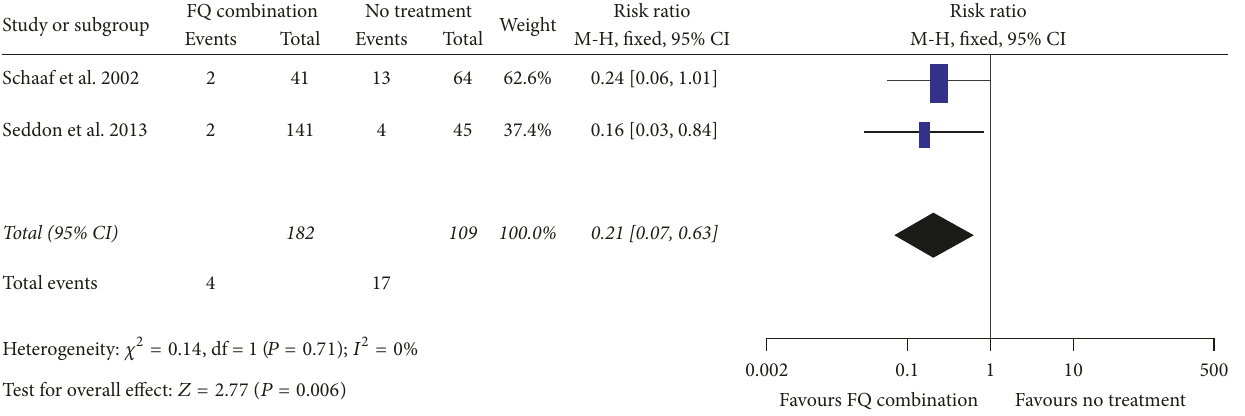
age who were initiated on chemoprophylaxis according to the index’s strain susceptibility and included high dose isoniazid, pyrazinamide, ethionamide, and ethambutol or high dose isoniazid, pyrazinamide, ethionamide, and ofloxacin daily for a period of six months. All children were followed up to thirty